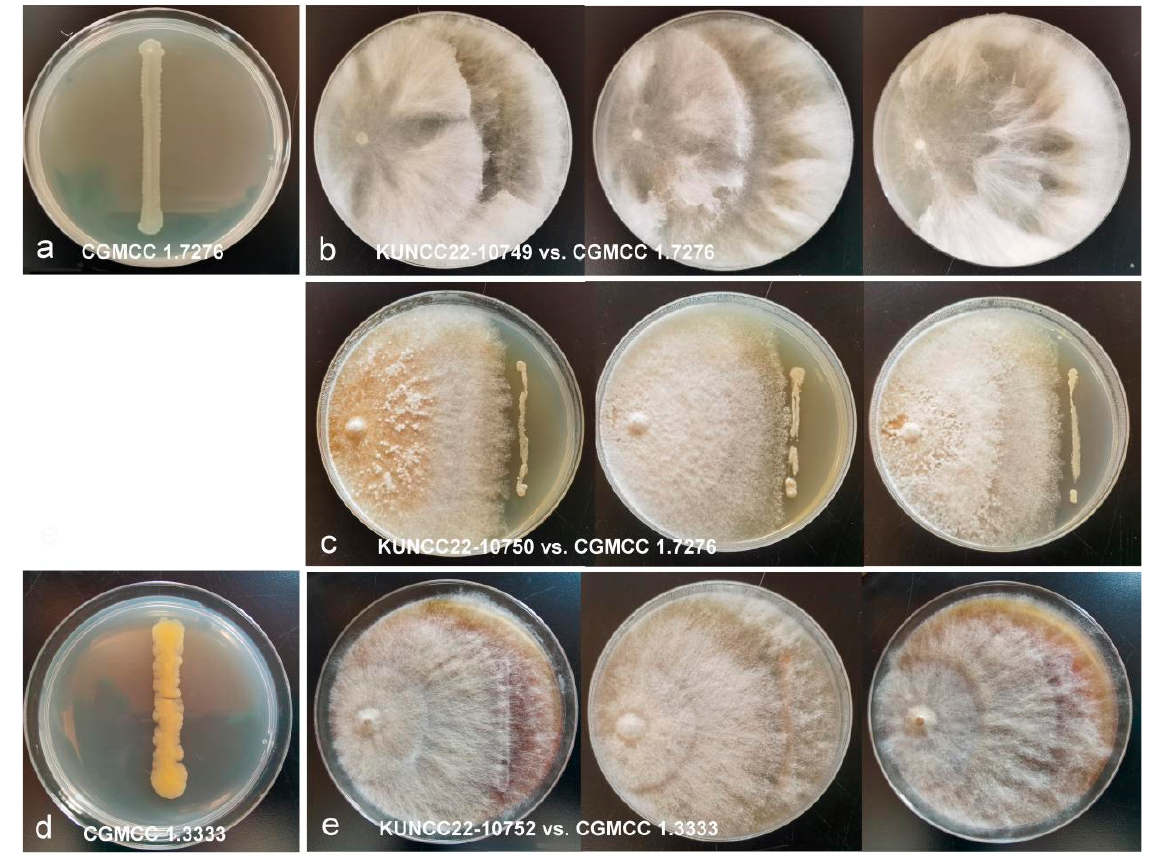
Figure 4. The images of two bacterial pathogens that were co-cultivated with the mango fungal endophytes on NA plates. ( a , d ) Control groups; ( b , c , e ) Endophyte-phytopathogen antagonism tests. 3.2.3. Effect of Endophytes on the Growth of Botrytis cinerea (CGMCC: 3.3790) The cultures of Botrytis cinerea were fast-growing, pale brown at the center, and white at the margins, and reached a diameter of around 60 mm in PDA after 10 days, with- out sporulating. Daldinia sp. KUNCC22-10744 strain was fast-growing and overlapped Botrytis cinerea (Figure 5b) with an inhibition rate of 55.56 ± 1.73% (Table 2). Chaetomium sp. KUNCC22-10749 strain inhibited the growth of B. cinerea (Figure 5c) with an inhibi- tion rate of 52.02 ± 2.92% (Table 2) producing abundant aerial mycelium. Alternaria sp. KUNCC22-10760 strain inhibited the growth of B. cinerea (Figure 5d) with an inhibition rate of 67.15 ± 5.88% (Table 2) and the pathogen grew slowly, and mycelium was sparse. 3.2.4. Effect of Endophytes on the Growth of Penicillium digitatum (CGMCC: 3.15410) The cultures of Penicillium digitatum were observed to be greenish, white at the margin, and a single colony in PDA reached 35–40 mm in diameter with sporulation after 10 days. Daldinia sp. KUNCC22-10744 strain was a fast-growing and overlapped pathogen (Figure 5f) with an inhibition rate of 51.16 ± 5.59% (Table 2). Rosellinia sp. KUNCC22-10751 strain was fast-growing while pathogens grew slowly (Figure 5g) at an inhibition rate of 60.83 ± 2.88% (Table 2). Figures 6–9 show the Inhibition rates of different fungal endophytes to GCMCC: 1.7276, GCMCC: 1.3333, GCMCC: 3.3790, and GCMCC: